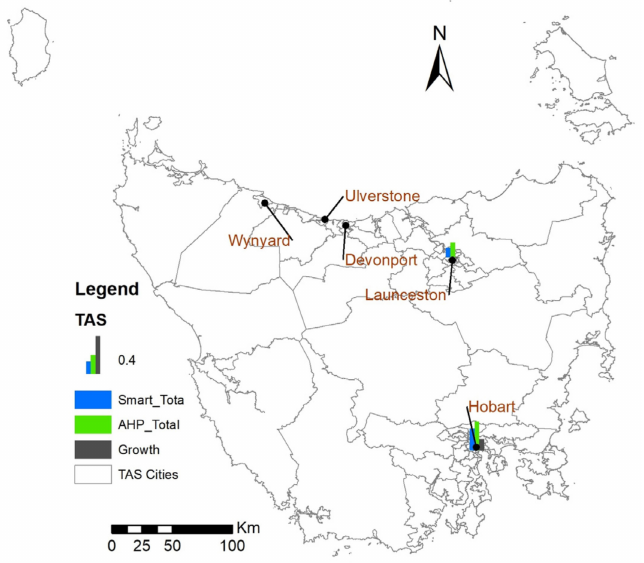
Figure 15. Five smart cities of Tasmania with preference and growth